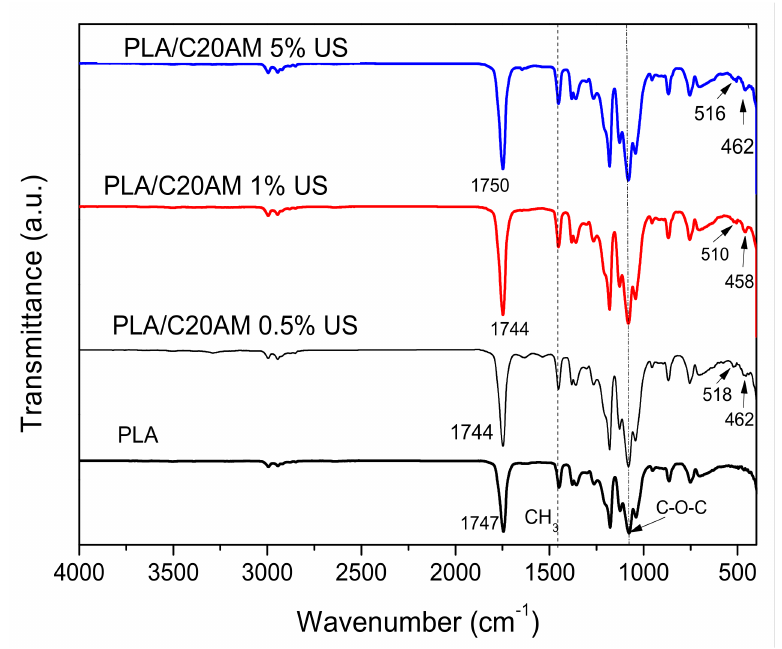
Figure 6. FT–IR spectra of nanocomposites with PLA and modified nanoclay at 0.5, 1, and 5% by weight.